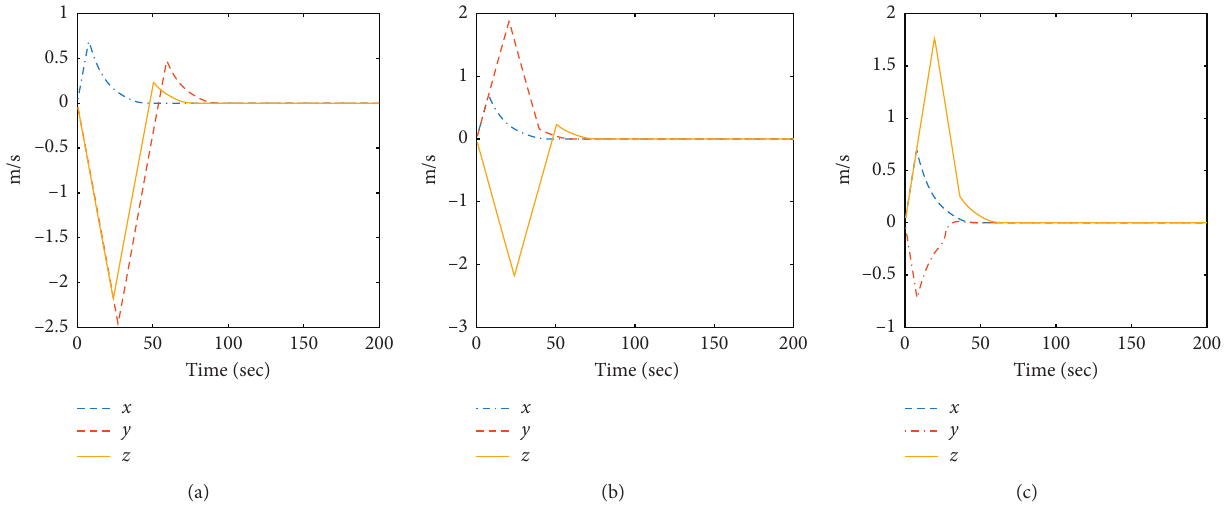
Figure 6: The curves of the relative velocity error. (a) Sat1. (b) Sat2. (c)